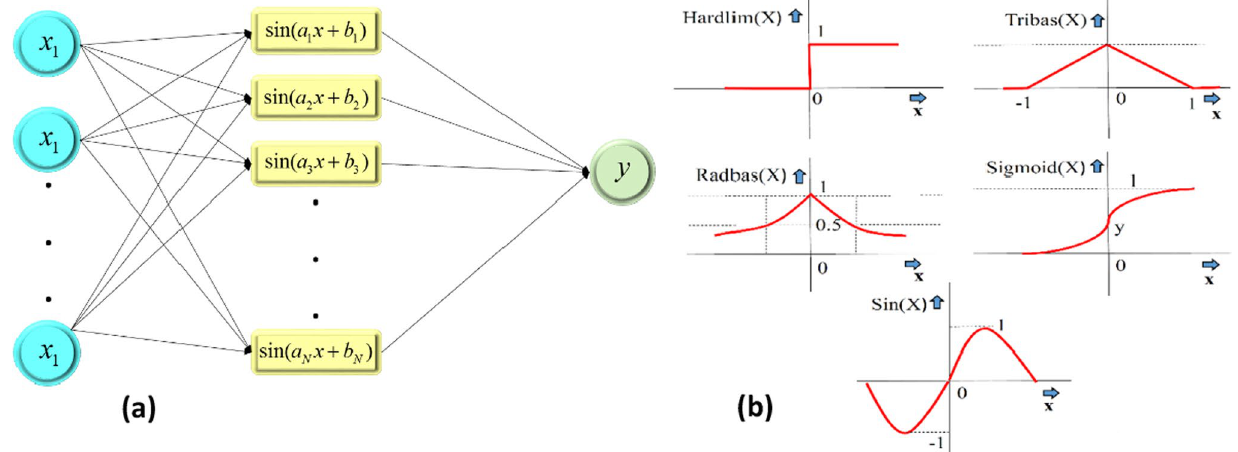
Fig. 3 a Structure of ELM network b Various activation functions (AFs) in ELM